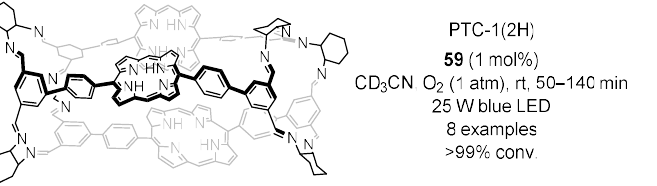
Figure 14. Results obtained in the aerobic photo-oxidative coupling of benzylamines to N -benzylidene benzylamines 2 catalyzed by 59 .